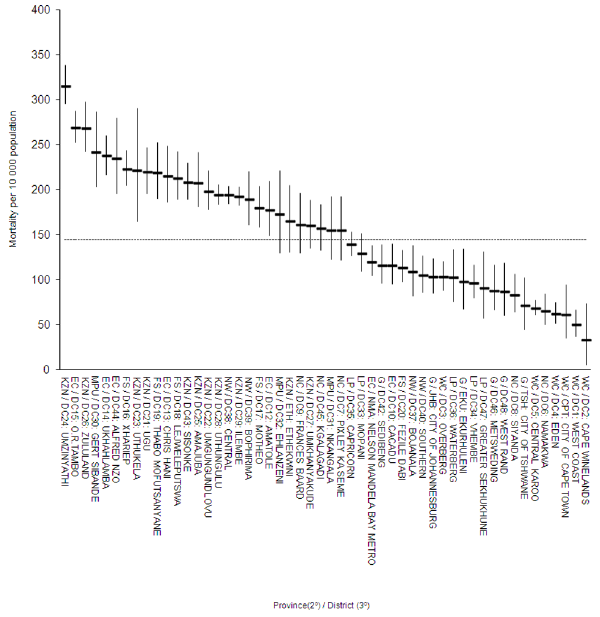
Figure 3. Descending district level adult mortality proportions with 95% confidence intervals and highlighting significantly high or low tertiary (districts) areas, South Africa, 2007 (KZN Kwazulu-Natal: EC: Eastern Cape; MPU: Mpumalanga; FS: Free State; NW: North West; NC: Northern Cape; LP: Limpopo; G: Gauteng; WC: Western Cape). Dashed line represents the national average.